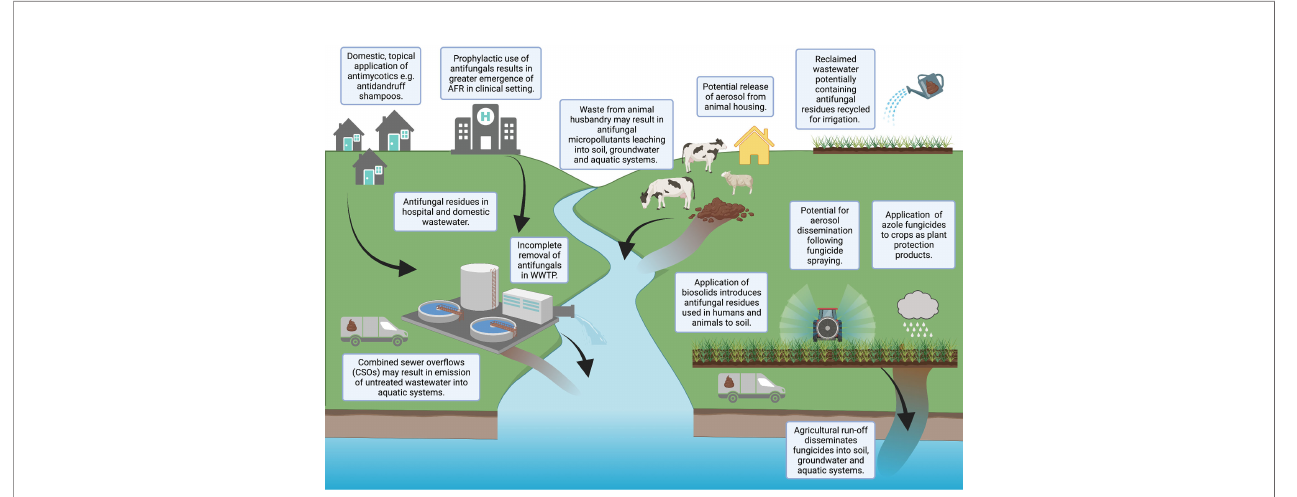
FIGURE 1 | Potential pathways for antifungals to enter the environment. Created with